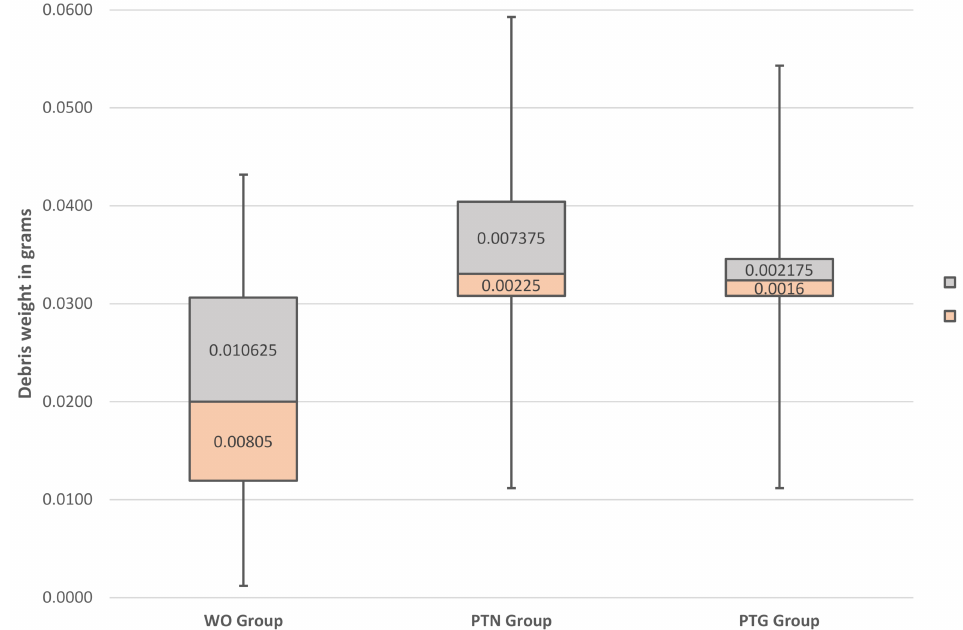
Figure 5. Box plot showing comparison of median and interquartile ranges of debris weight in grams